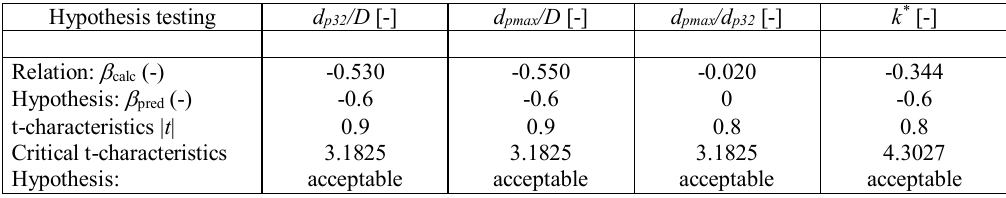
Table 11. Dimensionless correlations – hypothesis testing; high-shear tooth impeller